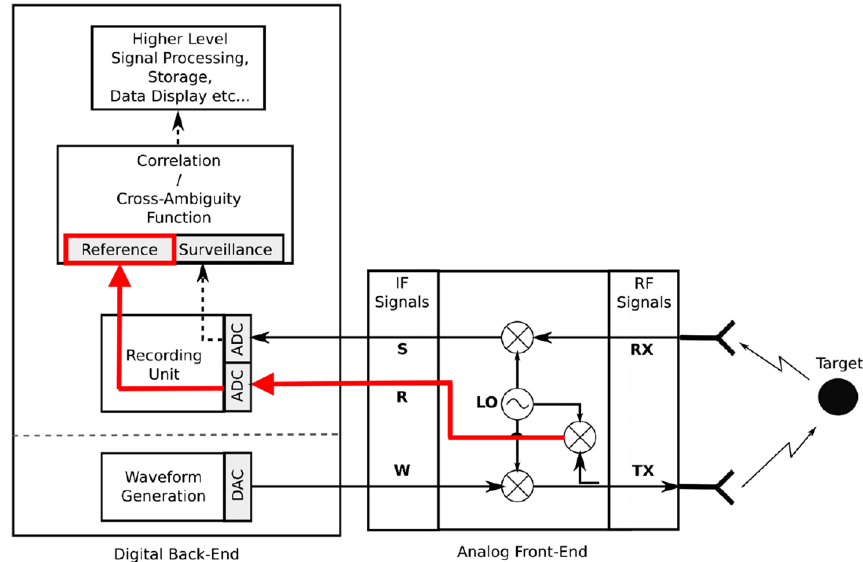
Fig. 15 Block diagram of a continuous emission noise radar. Solution (b): the reference is the record of the transmitted signal at the antenna